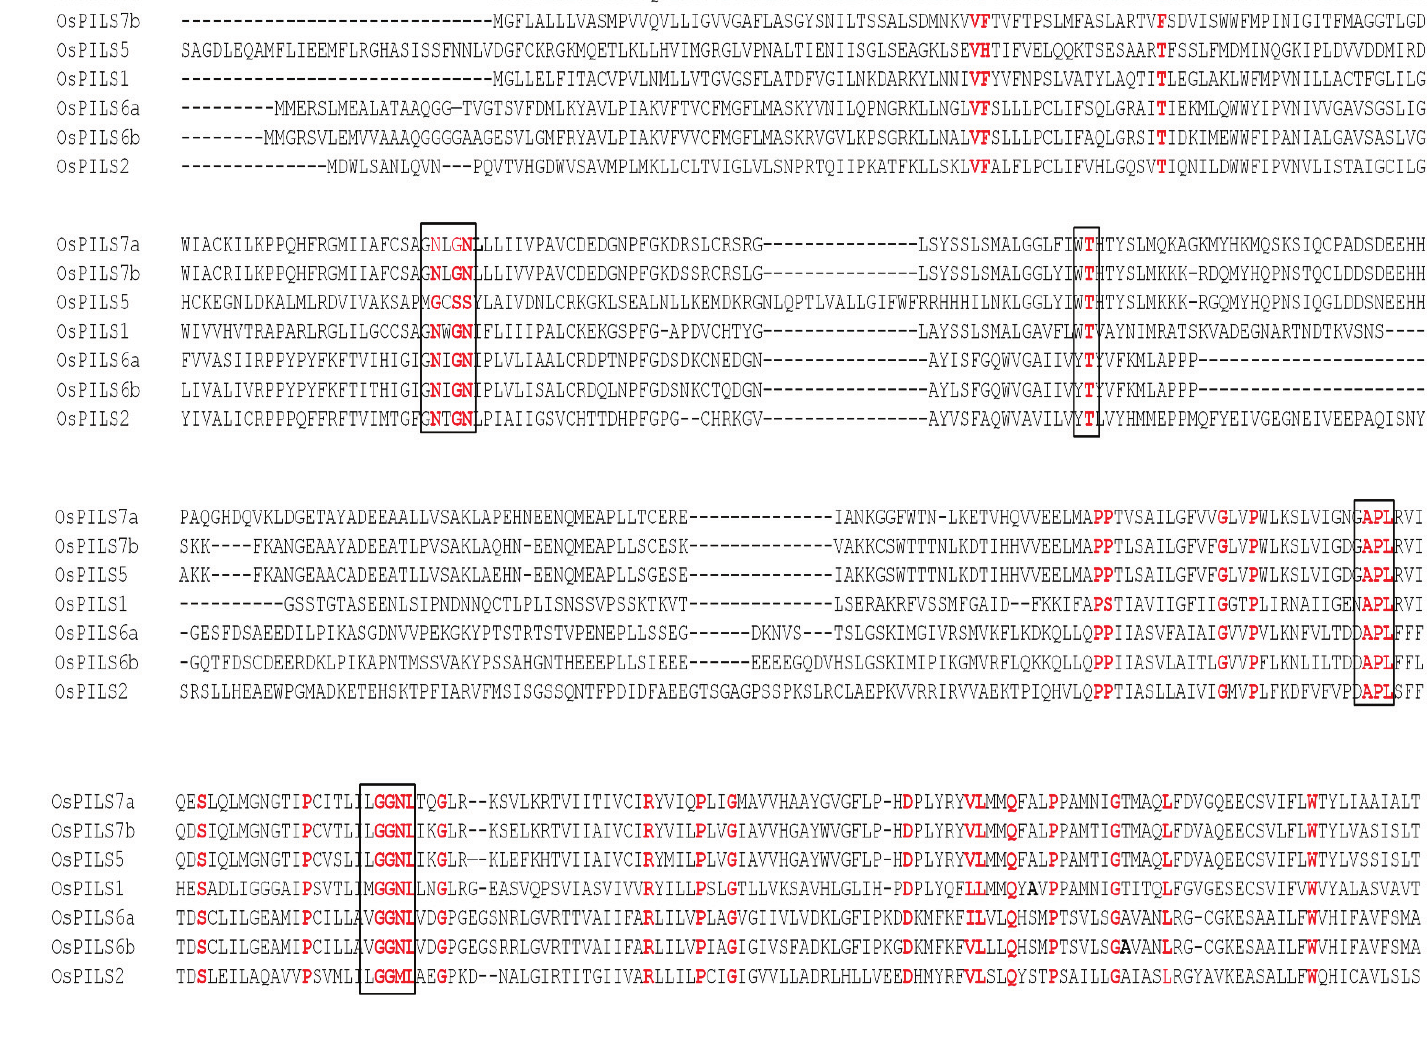
Figure 4. Multiple sequence alignment of OsPILS proteins. Alignment shows presence of several conserved amino acid residues and motifs in the N- and C-terminal region. The major conserved motif found in the N-terminal region is N-x-G-N (in box). The C-terminal region contains conserved A-P-L and G-G-N-L (in box) consensus sequences. Although the central hydrophilic region of the OsPIL protein is highly dynamic, it still contains conserved threonine (boxed) in the central hydrophilic